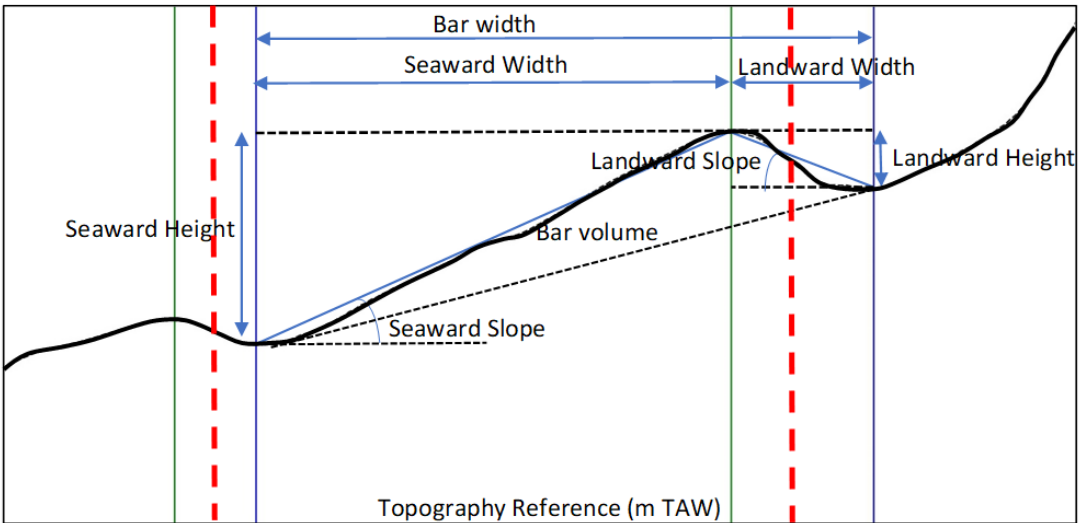
Figure 4. Morphometric bar parameters computed using bar crest and trough positions indicated by green and blue vertical lines respectively. The locations of the corresponding inflection points are marked by the dashed red lines.